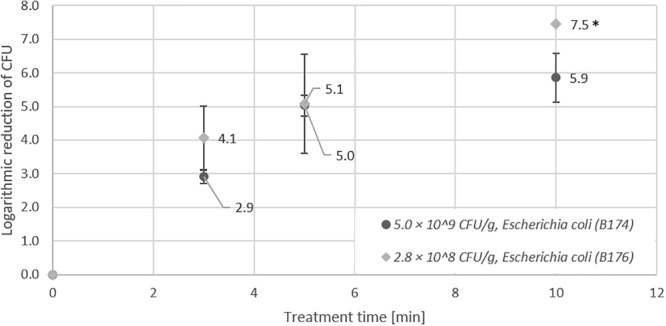
Effect of CAPP treatment of strains E. coli B174 and E. coli B176 on lentil seeds. For both E. coli strains a high initial inoculation of lentil seeds was performed prior to treatment of seeds for 3, 5, and 10 min in the DCSBD. Logarithmic reductions were represented as log10 CFU/g ± standard deviation. The limit of detection was 100 CFU/g. Logarithmic reduction below the limit of detection is indicated by an asterisk.